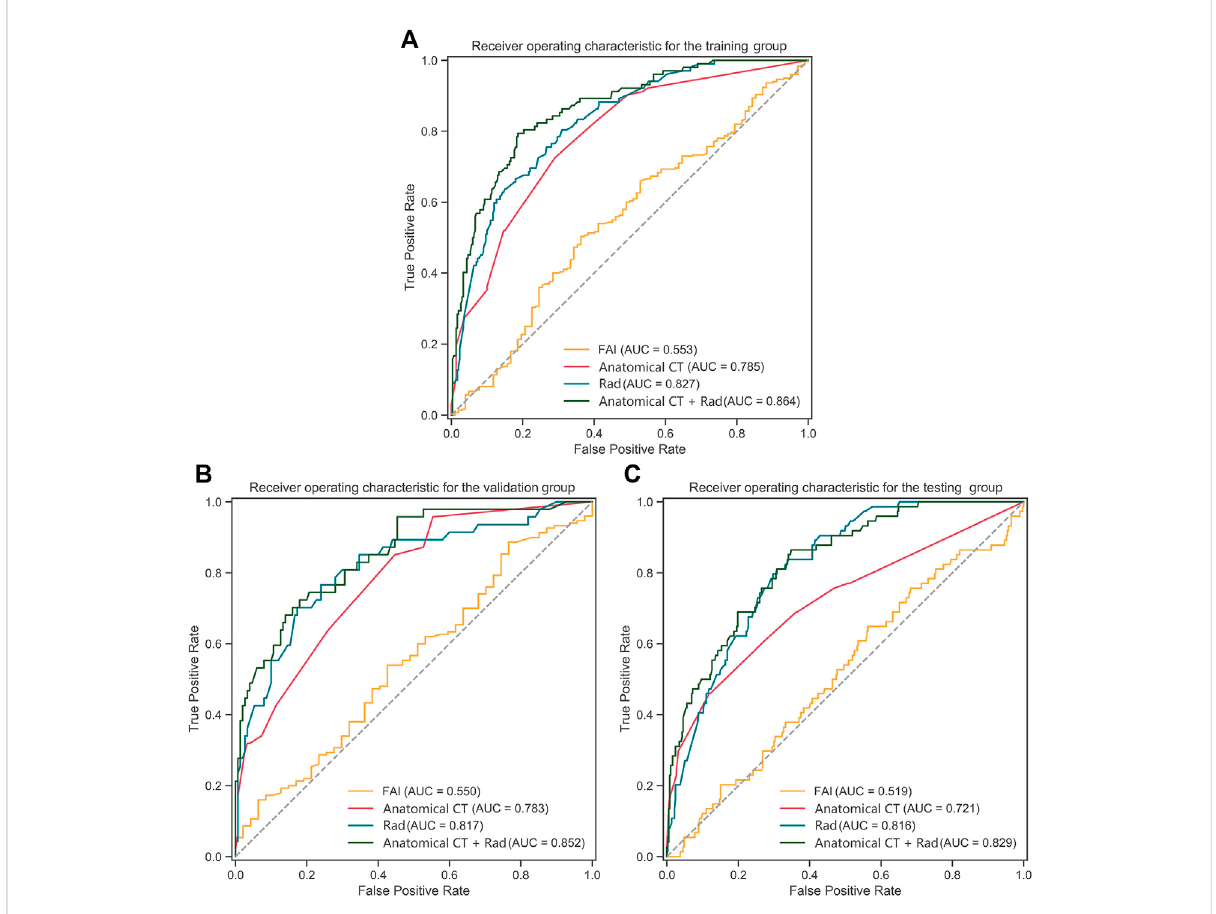
FIGURE 6 ROCcurvesofRad-signature,FAI,anatomicalCTandcombinedmodel(Rad-signatureandanatomicalCT)in (A) thetraining, (B) validation,and (C) testing groups. ROC, receiver operating characteristic; AUC, area under the ROC curve; Rad, Rad-signature; FAI, fat attenuation